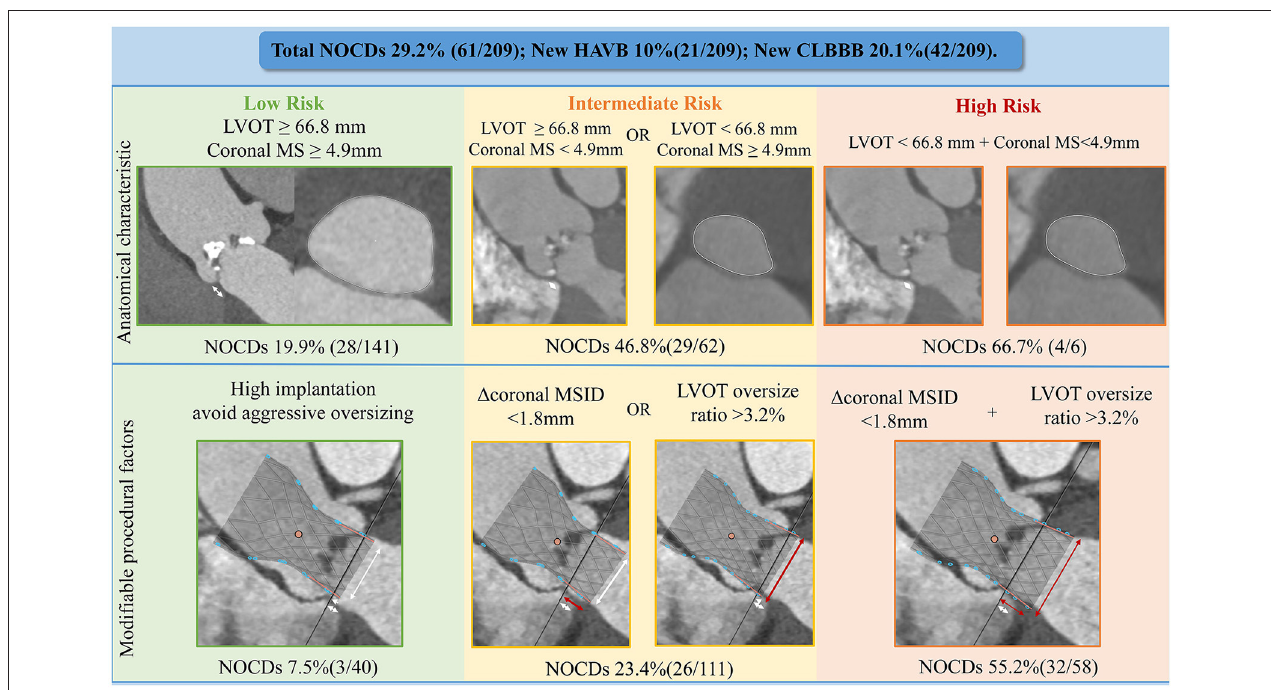
FIGURE 4 | Predictive model of NOCDs. NOCDs, new-onset conduction disturbances; HAVB, high-grade atrioventricular block; CLBBB, complete left bundle branch block; LVOT, left ventricular outflow tract; 1 coronal MSID, coronal MS length minus implantation depth on CT.